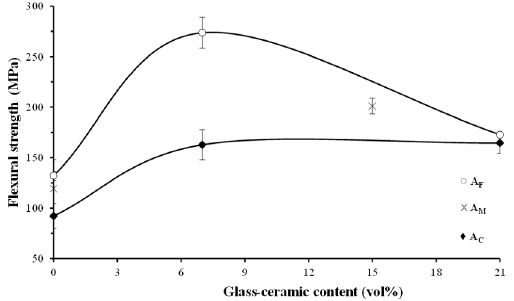
Figure 6. Flexural strength in function of LZSA content of the alumina ceramics and LZSA/alumina composites.